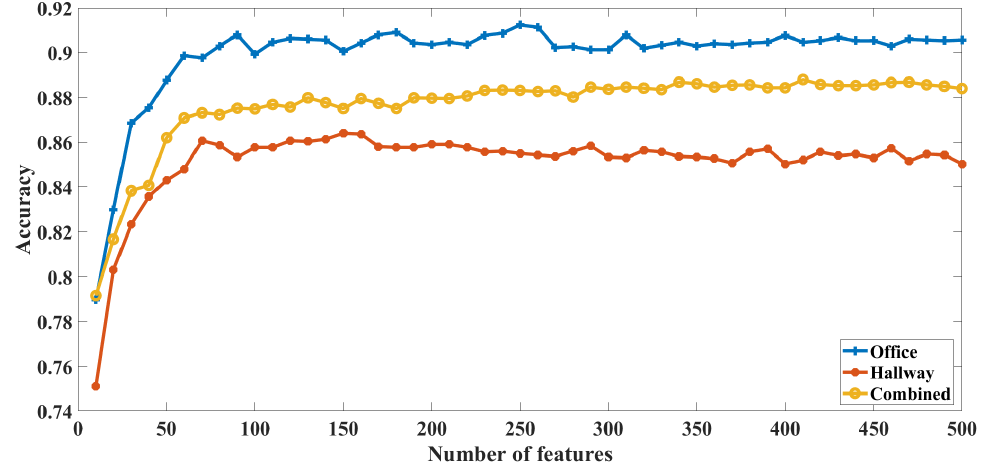
Figure 17. The effect of the number of features on the overall system’s